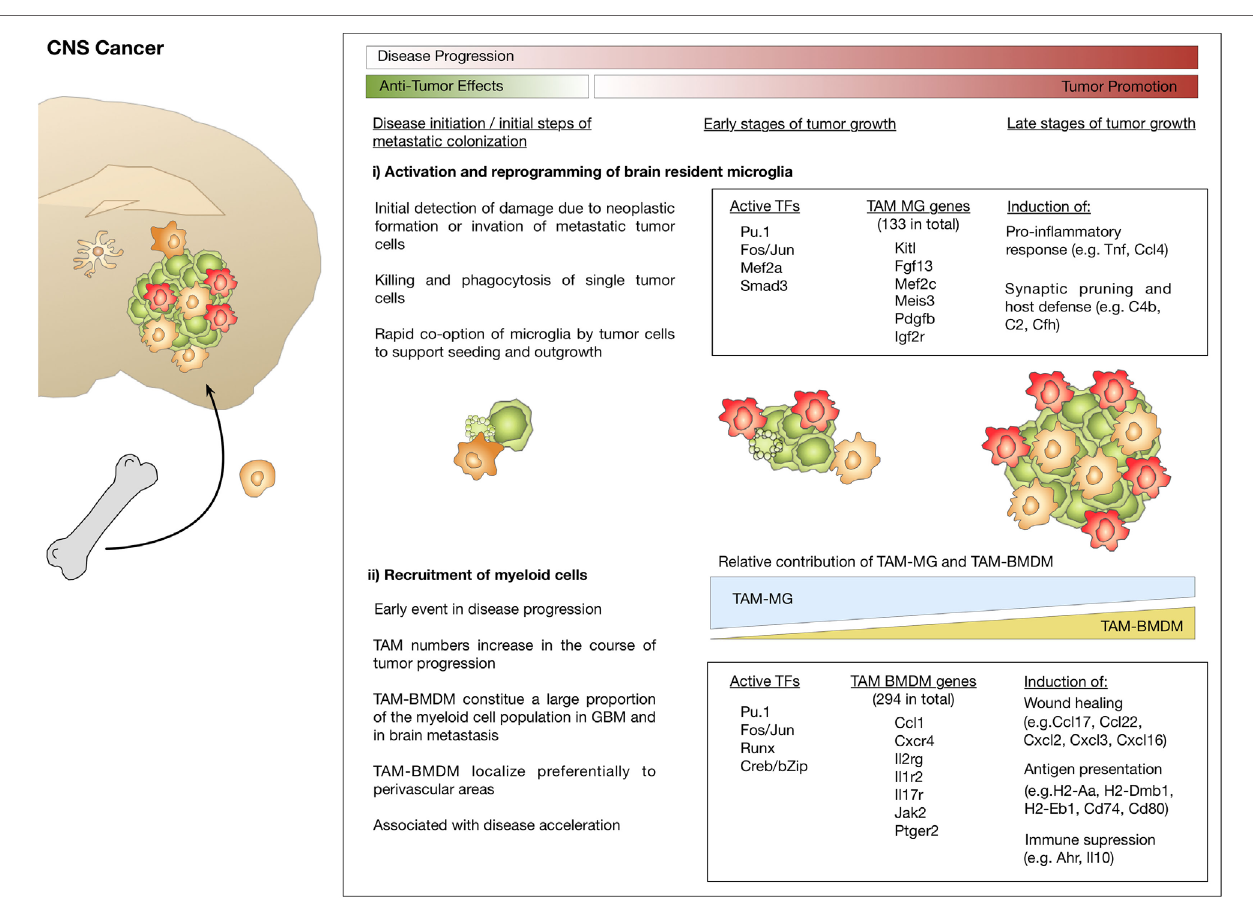
FiGURe 4 | Microglia and macrophage activation states and effector functions at different stages of disease progression in brain cancer. (i) Initial stages during neoplastic transformation in primary brain cancers or tumor cell seeding in brain metastasis are detected by microglia. As part of their role in host defense, microglia induce apoptosis in cancer cells. Tumor cells that escape microglia-mediated killing rapidly co-opt them and exploit their function to foster tumor growth. (ii) Brain tumor formation is associated with pronounced recruitment of macrophages from the periphery that starts at early stages and leads to disease acceleration. Transcriptomic analysis identified gene signatures that define tumor-associated microglia (TAM-MG) and macrophages (TAM-BMDM). The respective signatures indicate that TAM-MG rather induce pro-inflammatory responses and exert host defense functions while TAM-BMDMs were associated with wound healing, antigen presentation, and immune